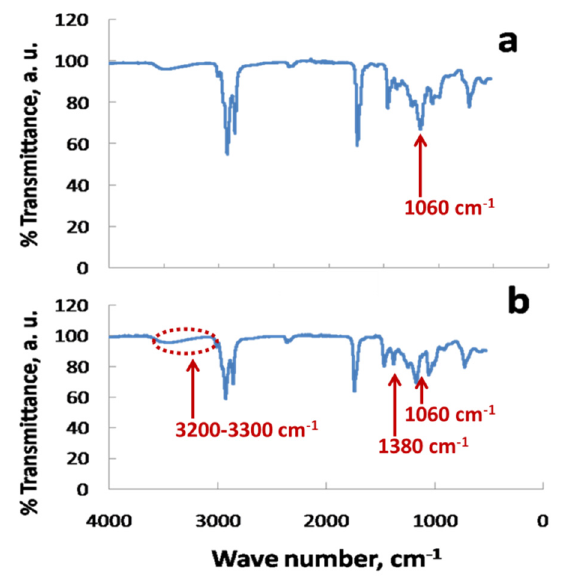
Figure 12. IR spectrum for ( a ) cardoon biodiesel and ( b ) the biolubricant obtained with 2,2-dimethyl-1,3-propanediol.